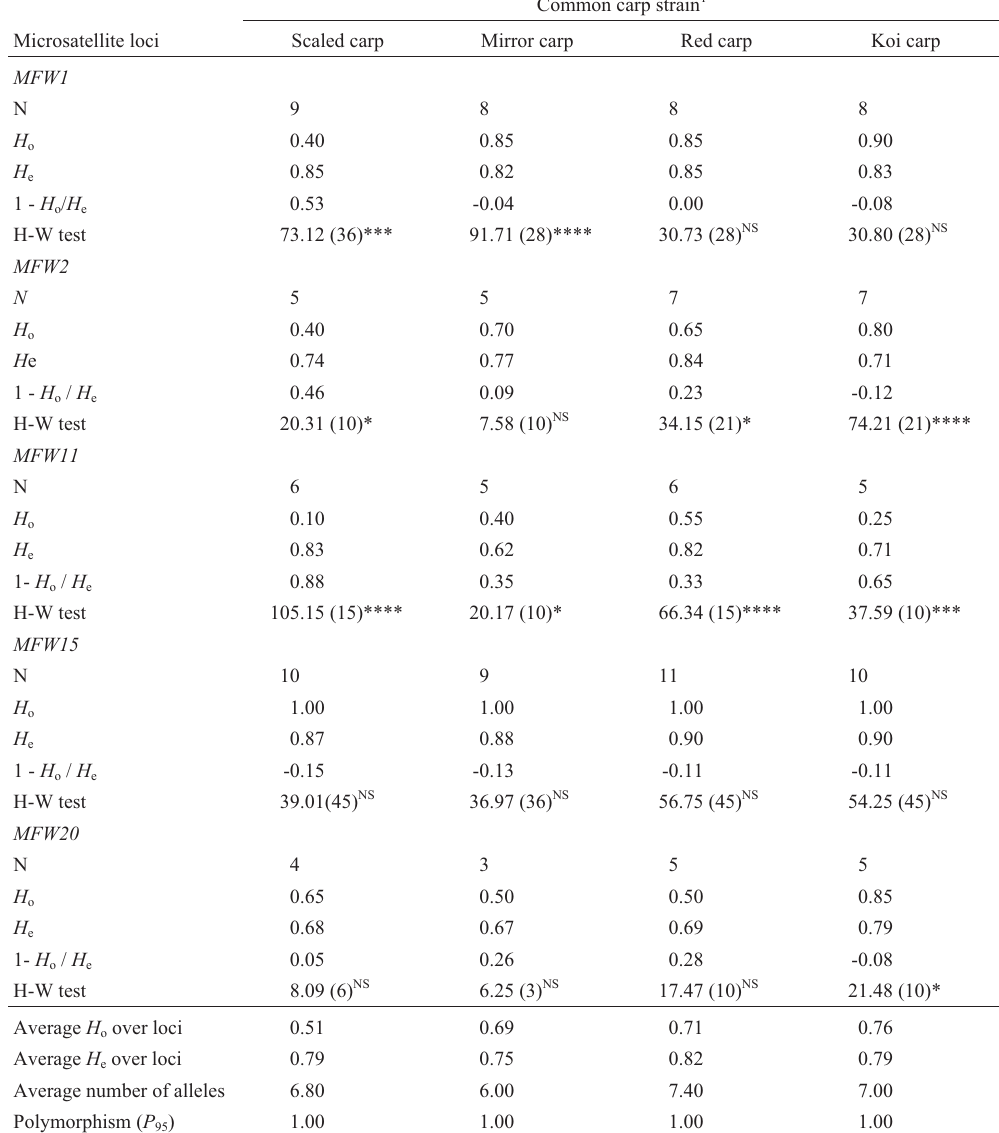
Table 1 - Allelic variations ( N = number of alleles, H o = observed heterozygosity, H e = expected heterozygosity) and deviation from Hardy-Weinberg (H-W) expectations ( (cid:3) 2 values) at five microsatellite loci in twenty five fish from each of the four common carp strains